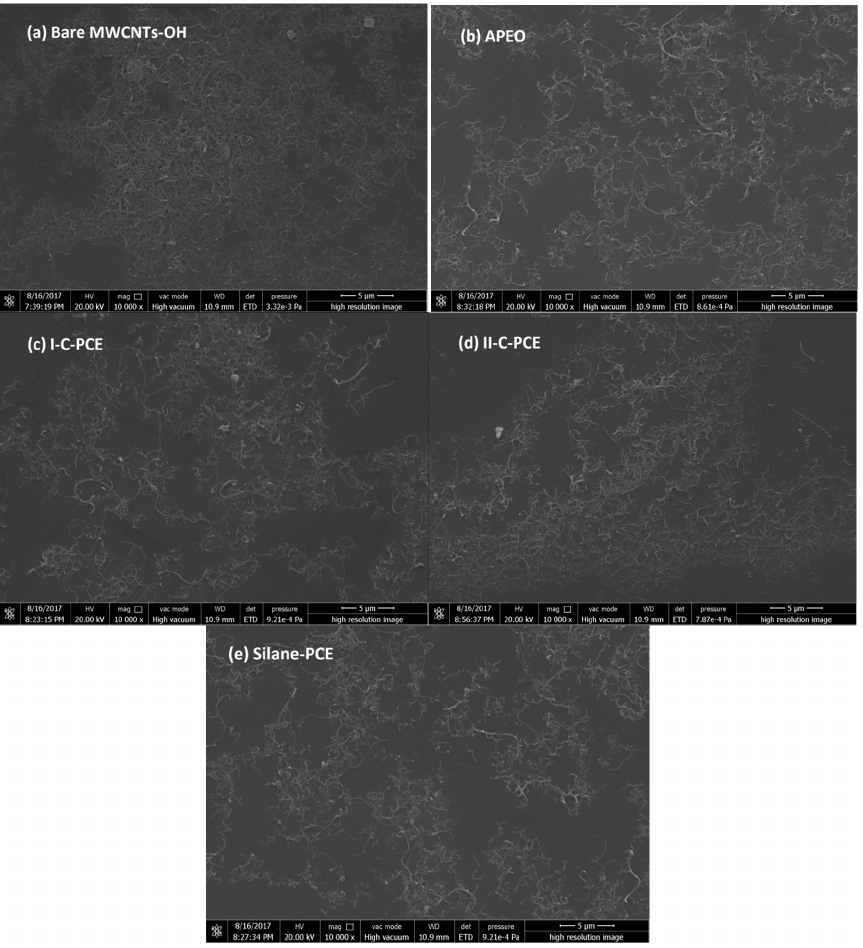
Figure 6. SEM images of MWCNTS–OH with different surfactant. ( a ) Bare MWCNTs–OH; ( b ) APEO; ( c ) I-C-PCE; ( d ) II-C-PCE; and ( e ) Silane-PCE. ( c ) I-C-PCE; ( d ) II-C-PCE; and ( e )